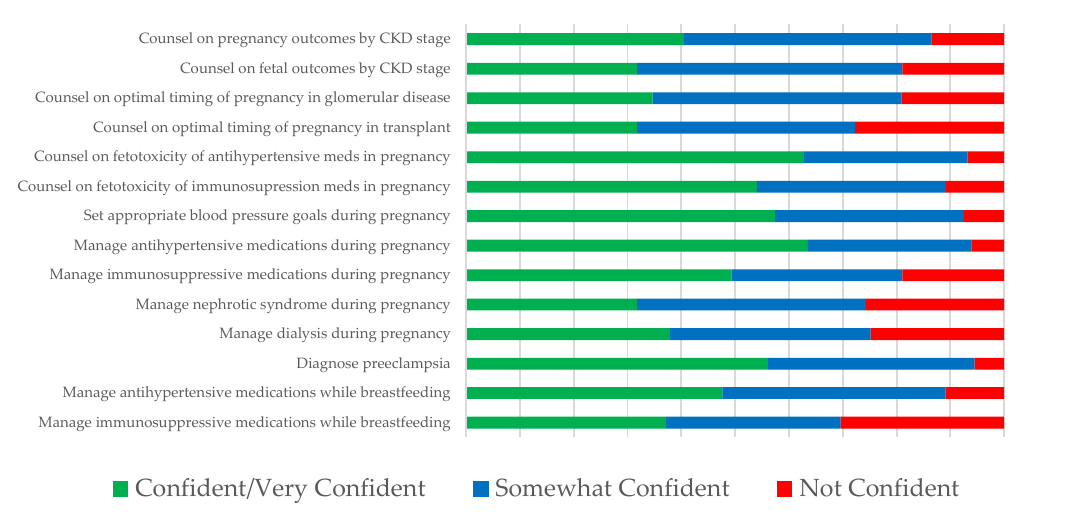
Figure 5. Nephrologists’ confidence managing pregnancy-related topics.